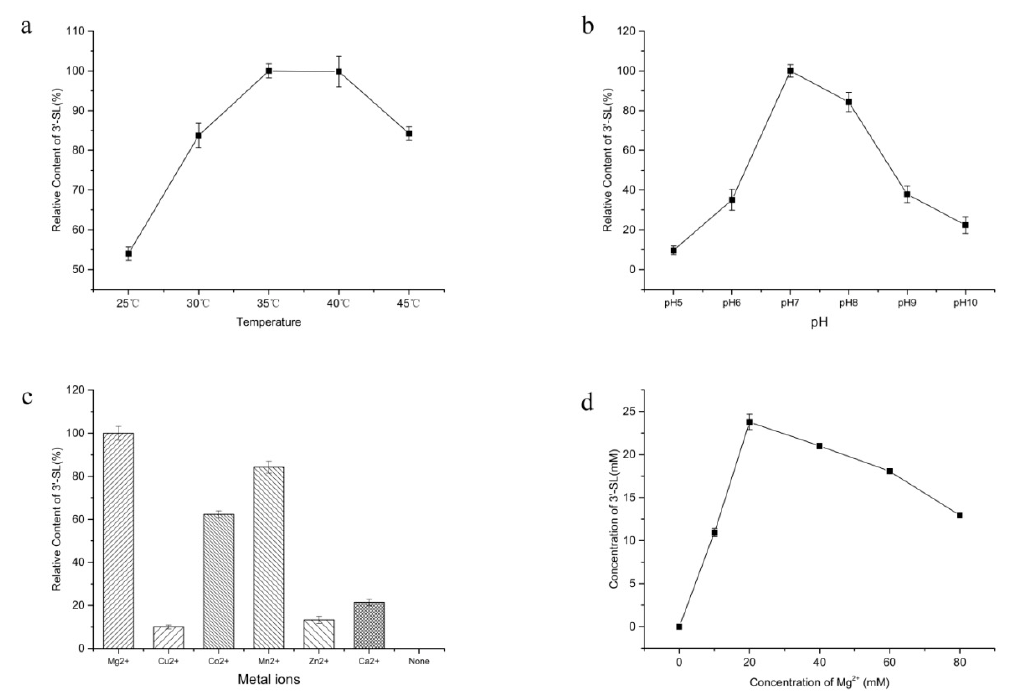
Figure 6. E ff ect of pH, temperature, and metal ions on the production of 3 (cid:48) -SL. ( a ) E ff ect of temperature on the reaction rate of 3 (cid:48) -SL biosynthesis; ( b ) E ff ect of pH on the reaction rate of 3 (cid:48) -SL biosynthesis; ( c ) E ff ect of di ff erent metal ions on the reaction rate of 3 (cid:48) -SL biosynthesis; ( d ) E ff ect of Mg 2 + concentration on the production of 3 (cid:48)